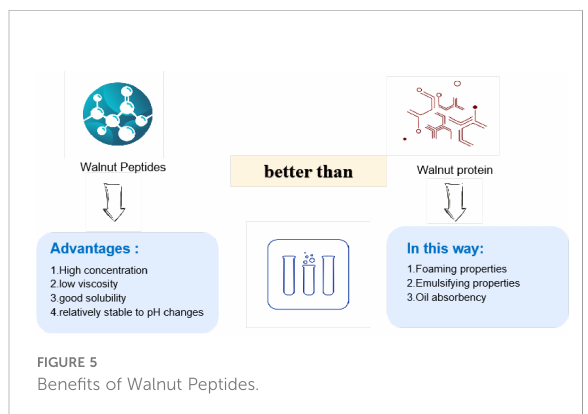
FIGURE 5 Bene fi ts of Walnut